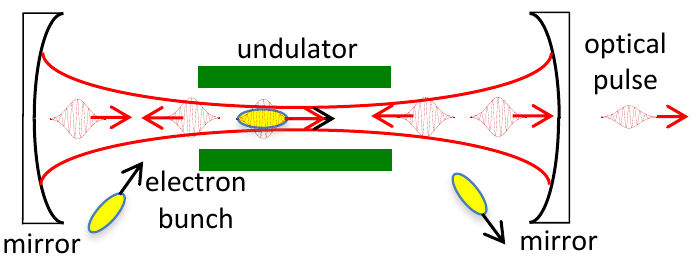
Figure 1. Schematic representation of a typical layout for an FEL oscillator. The electron beam consisting of electron pulses is guided through the undulator and around the mirrors. The optical pulse that is amplified within the undulator is recirculating within the resonator and extracted through one of the mirrors. Reproduced with permission from [1]. Copyright Springer,